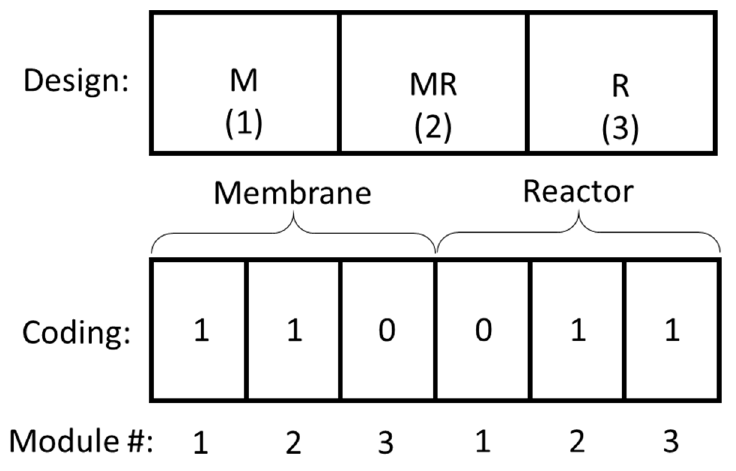
Figure 11. An example of the encoding process to convert a given modular design to its coded form for the genetic algorithm.